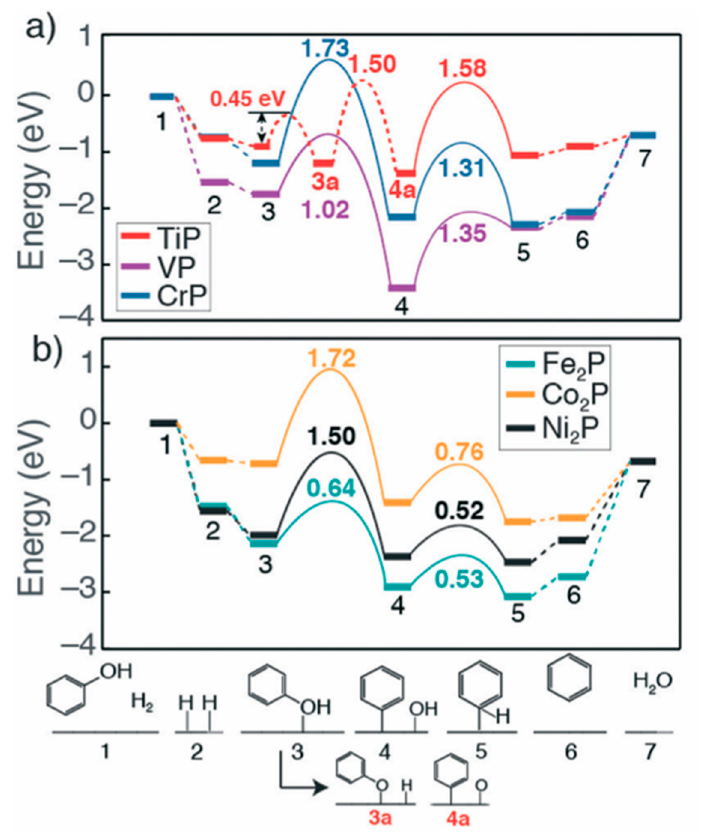
Figure 15. Potential energy landscape for phenol deoxygenation reaction over ( a ) TiP, VP and CrP and ( b ) Fe 2 P, Co 2 P and Ni 2 P surfaces. Reprinted with permission from Ref. [171]. Copyright 2017